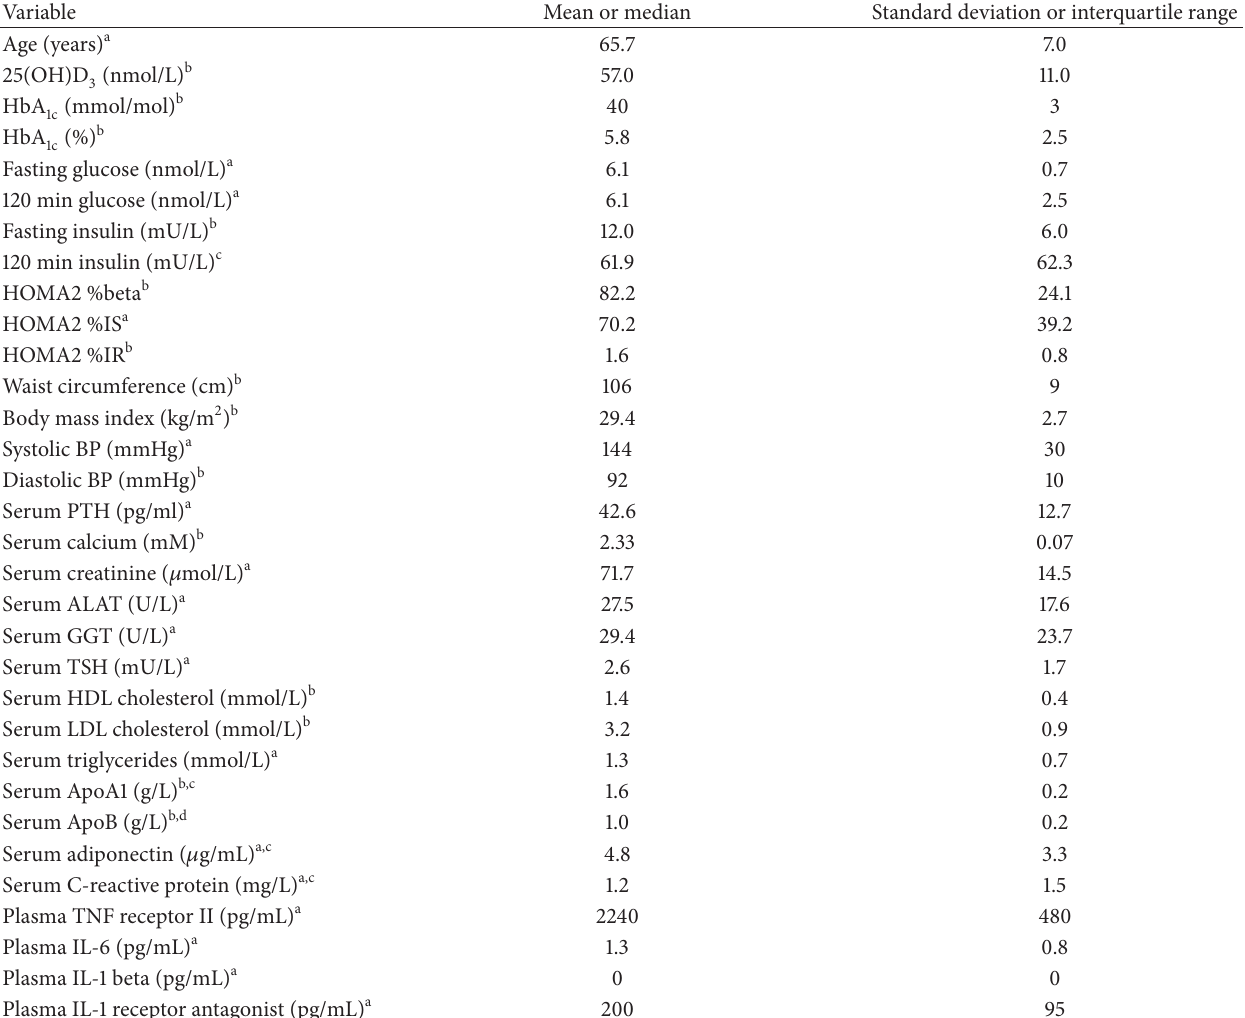
Table 1: Characteristics of the study population ( 𝑛 = 68 ) at the start of the supplementation